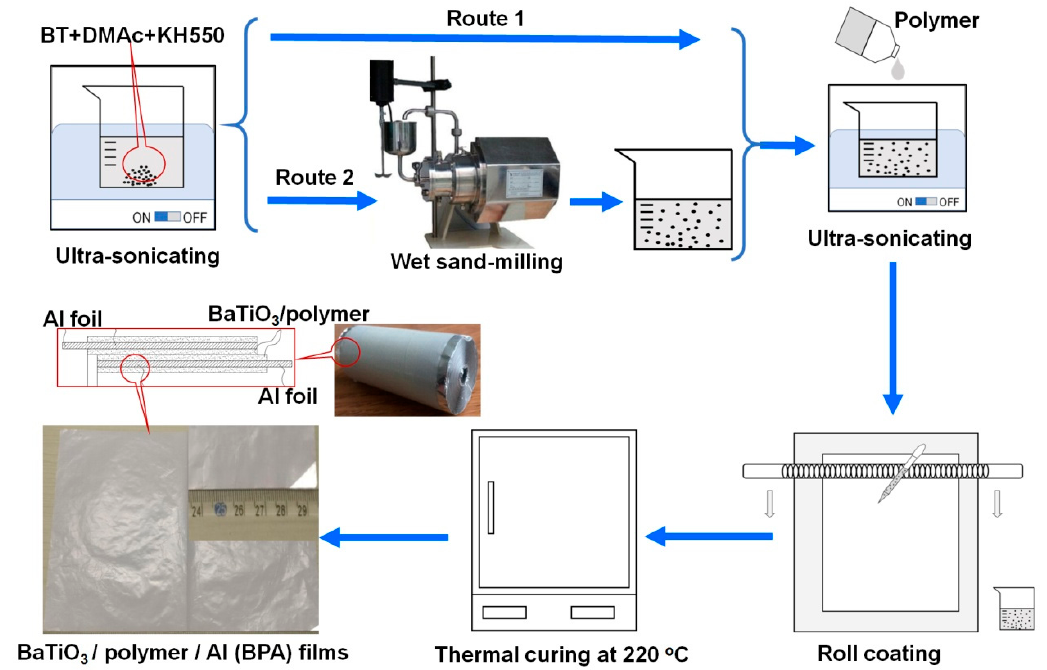
Figure 1. Schematic expression of the routes for the fabrication of BPA composite films.